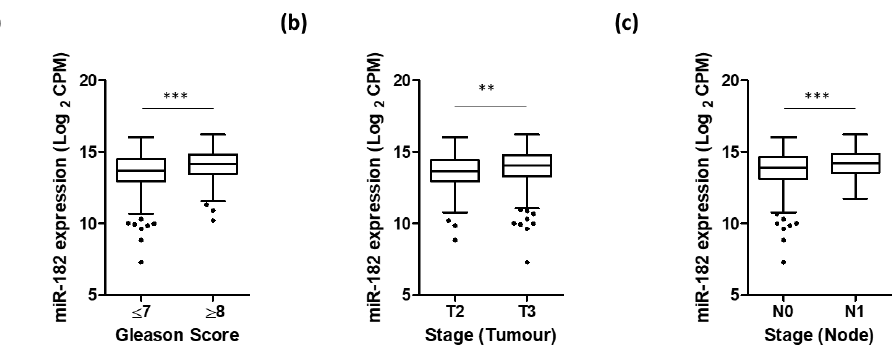
Figure 2. Higher expression of miR-182 is associated with more advanced prostate disease. UCSC Xena analysis of TCGA PRAD samples shows expression of miR-182 is significantly higher in patients with ( a ) Gleason score ≥ 8 ( n = 211) compared to those scored ≤ 7 ( n = 334), ( b ) pathological stage T3 ( n = 310) compared to T2 ( n = 215), and ( c ) pathological stage N1 ( n = 81) compared to N0 ( n = 368). (All Welch’s t -test, ** p < 0.01, *** p < 0.001). n = number. Table 2. Functional enrichment analysis of miR-182 related to EMT. Table shows the significant association of miR-182 target genes with Gene Set descriptions related to EMT. Analysis performed using clusterProfiler in CancerMIRNome. Knowledge Count Adjusted ID Description Target Gene Symbol Base /Total p -Value 1 KEGG